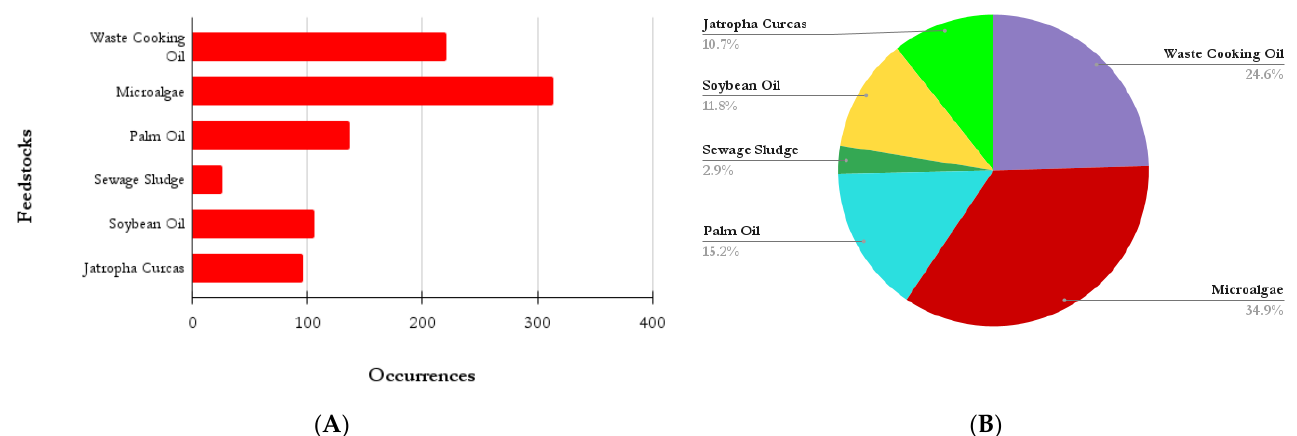
Figure 11. ( A ) Number of occurrences mentioning different feedstocks in the titles of their respective articles. ( B ) Ratio showing the percentage of articles on specific feedstocks that mention them in their respective titles.